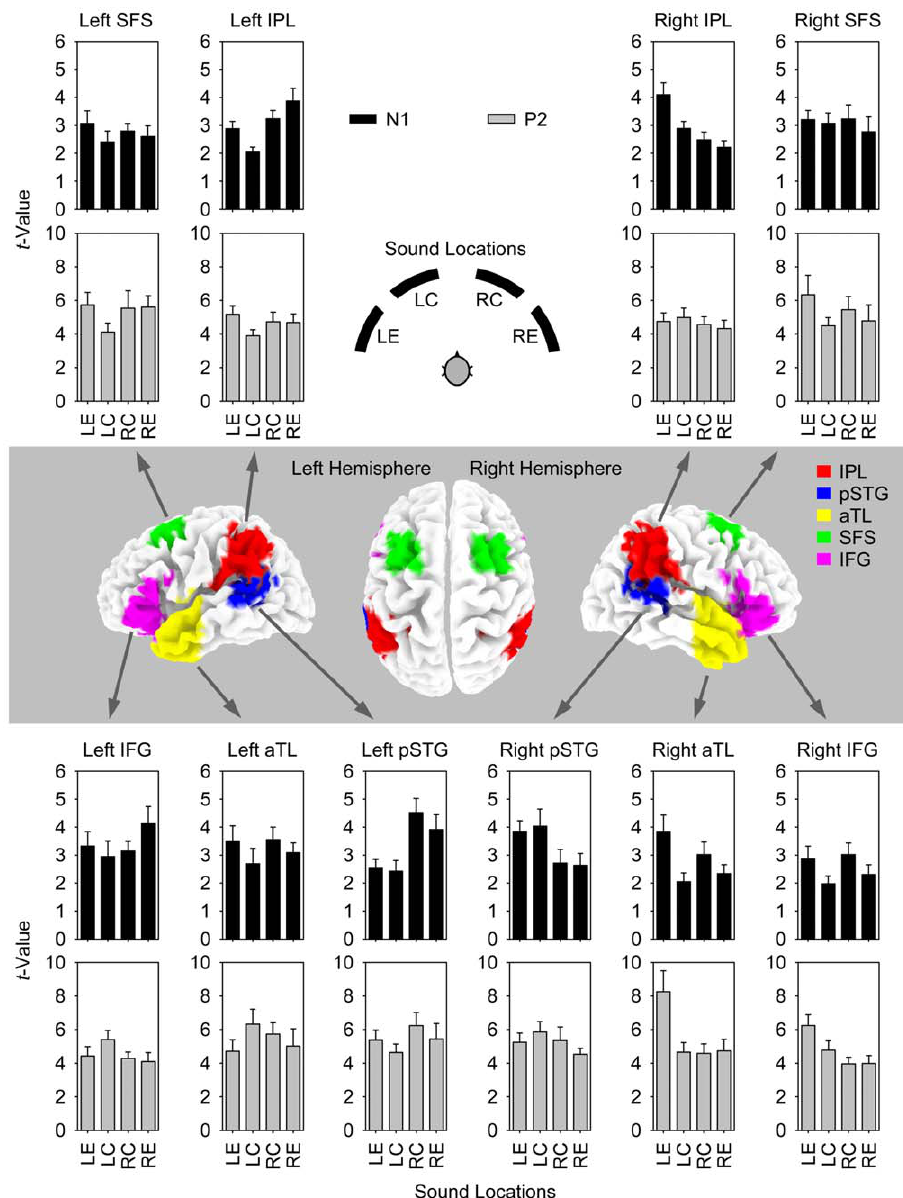
Figure 4. ROI-analysis of the five main cortical regions processing auditory information beyond primary auditory cortex. ROIs were posterior superior temporal gyrus (pSTG), inferior parietal lobule (IPL), superior frontal sulcus (SFS), anterior temporal lobe (aTL), and inferior frontal gyrus (IFG). Analyses were conducted for activation of the whole ROI at the time of the N1 and P2 components of the responses to different sound locations (as in Fig. 3). ROIs are mapped onto the standard 3-D MNI brain template ‘‘Colin’’ of sLORETA. The plots show t -values as a function of sound location (error bars, standard errors across subjects; N1, black bars; P2 gray bars), resulting from contrasts of activations with a 40-ms prestimulus period of silence for the whole ROI. Data are as given in Table 1.